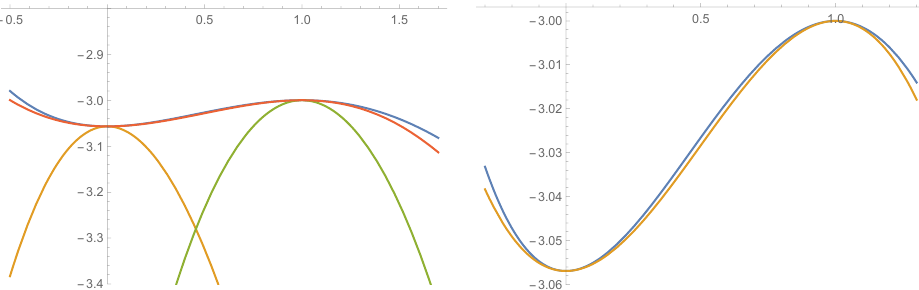
Figure 3. The profile of the scalar potential restricted to the straight line connecting vacua “1” and “2” (blue curve). Besides the previously determined globally bounding functions (in yellow and green), we also plot − 3 f 2 (orange curve), having both critical points as local extrema, and thus defining DW 12 the interpolating flow (zoomed on the right). The plots are both drawn in (cid:96) = 1 units.